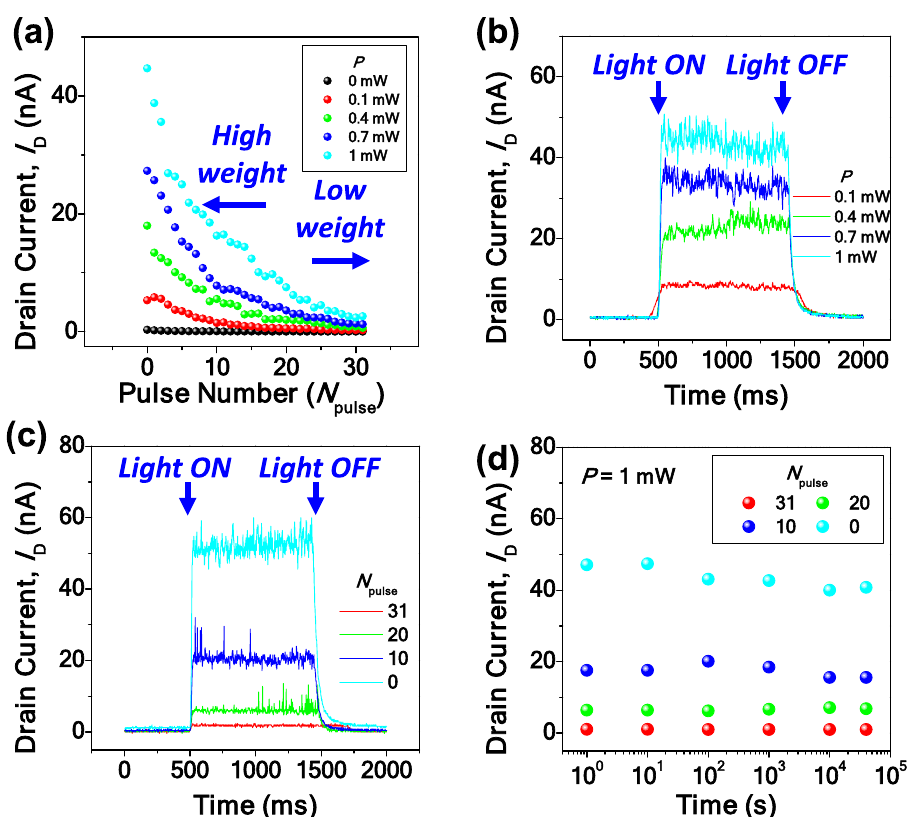
Figure 3. ( a ) I D versus N pulse for various P . The photoresponsivity is reduced by the depression. ( b ) Real-time I D for various P when N pulse is zero. I D is increased as P increases. ( c ) Real-time I D for various N pulse when P is 1 mW. I D is decreased as N pulse increases. ( d ) Retention characteristics of the MOST for various N pulse when P is 1